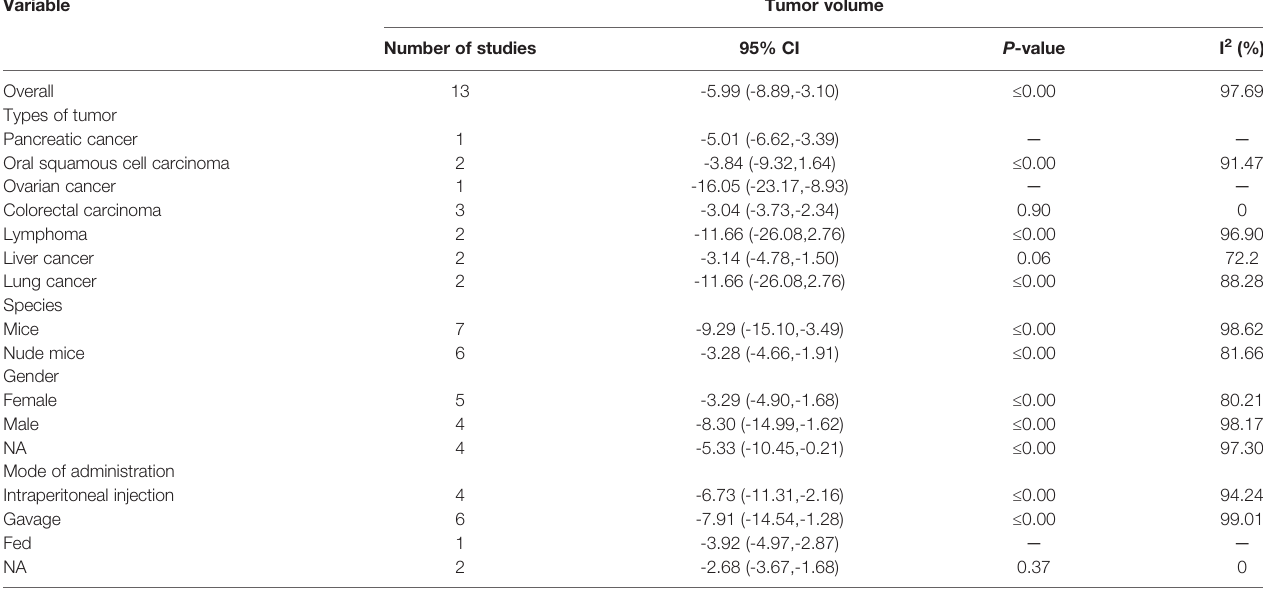
TABLE 2 | Sub-analysis of the effects of EVO on tumor volume.